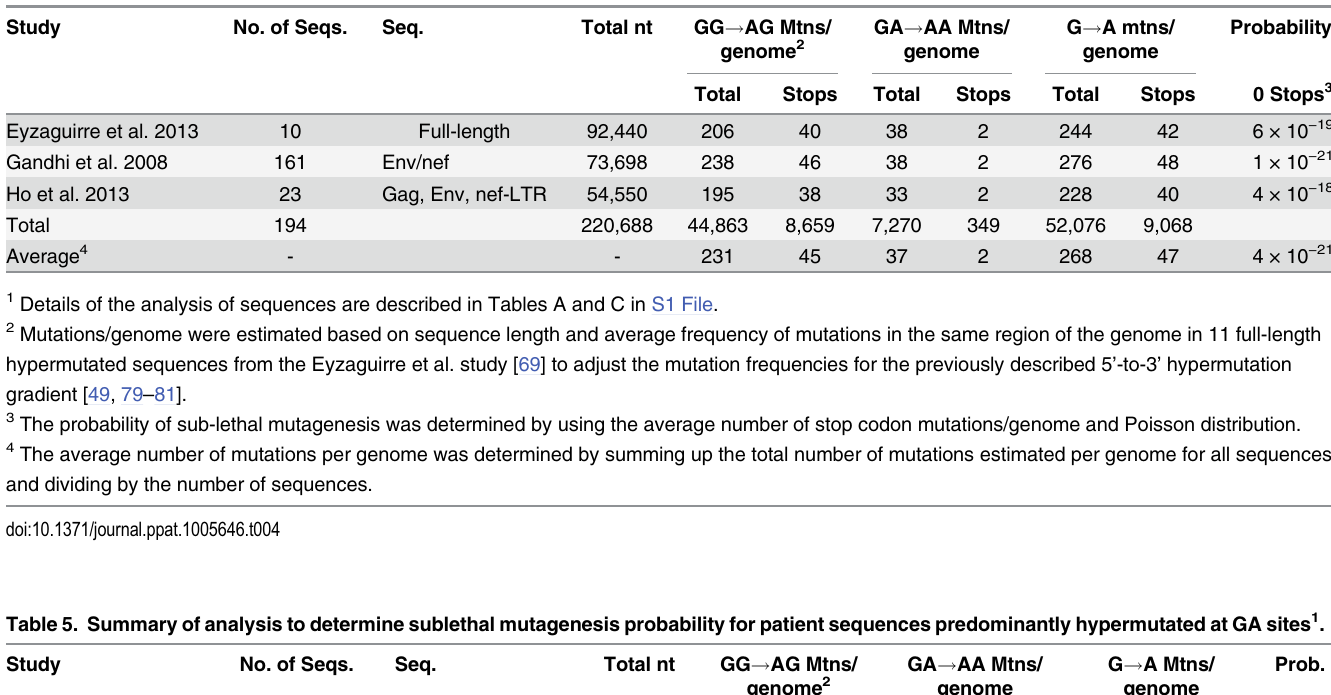
Table 4. Summary of analysis to determine sub-lethal mutagenesis probability for patient sequences that were predominantly hypermutated at GG sites 1 .